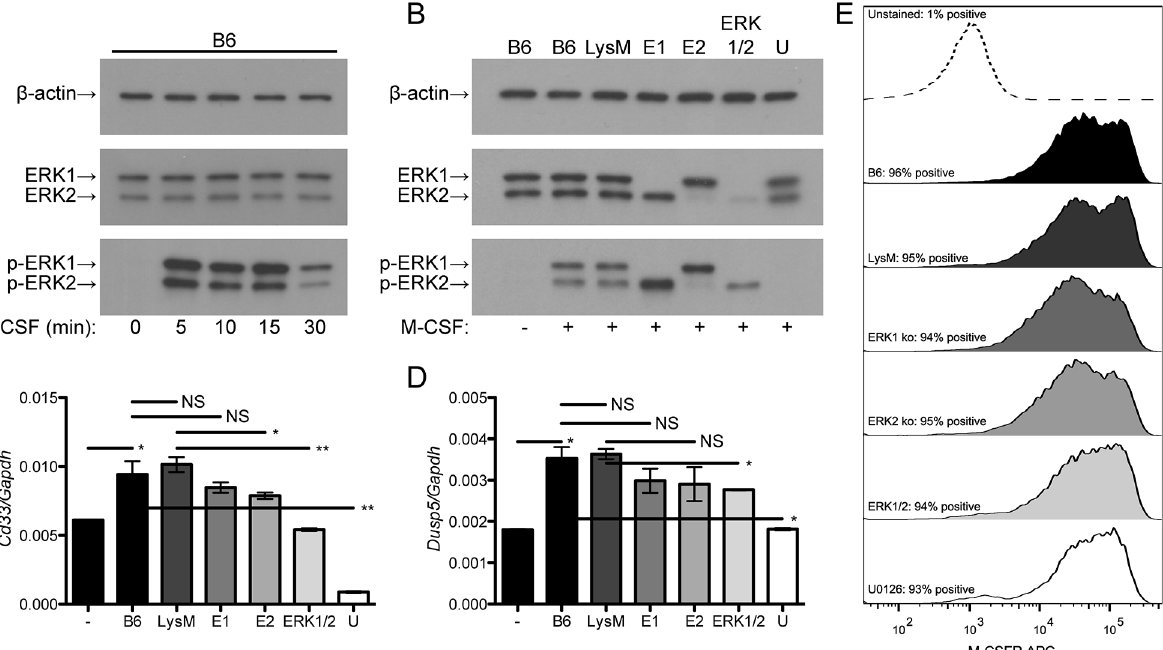
Fig 2. ERK signaling is required for some macrophage responses to M-CSF. (A) Wild-type bone marrow-derived macrophages were treated with 2 ng/ ml M-CSF for the indicated times, lysed, and analyzed by Western blotting. Data represent two independent experiments. (B) Bone marrow-derived macrophages were pre-treated for 30 min with U0126 or DMSO vehicle (all others) and then treated with 2 ng/ml M-CSF for 10 min, lysed, and analyzed by Western blotting. Densitometric values (in arbitrary units) for LysM, E1 and ERK1/2 respectively were 33.7, 31.9 and 32.3 for β -actin; 43.7, 36.1 and 6.81 for ERK2; and 31.3, 54.9 and 14.0 for p-ERK2. Data represent two independent experiments. (C) and (D) Bone marrow-derived macrophages were pre-treated for 30 min with U0126 or DMSO and then treated with 2 ng/ml M-CSF for 24 h. RNA expression was measured by qRT-PCR. Each data point represents mean ± standard deviation of triplicate samples. Data are representative of three independent experiments. (E) Bone marrow macrophages were pre-treated with U0126 or DMSO, treated with 2 ng/ml M-CSF for 24 h, collected by detaching the cells using PBS with 10 mM EDTA, stained with 2 μ g/ml anti-CD115, and analyzed by flow cytometry. Data represent two independent experiments. Labels: -, untreated; +, treated with M-CSF; B6, C57BL/6J; E1, Erk1 -/- ; E2, Erk2 flox/flox Lyz2 Cre/Cre ; U, U0126-treated C57BL/6J. ** : P < 0.01, * : P < 0.05, NS: P > 0.05.